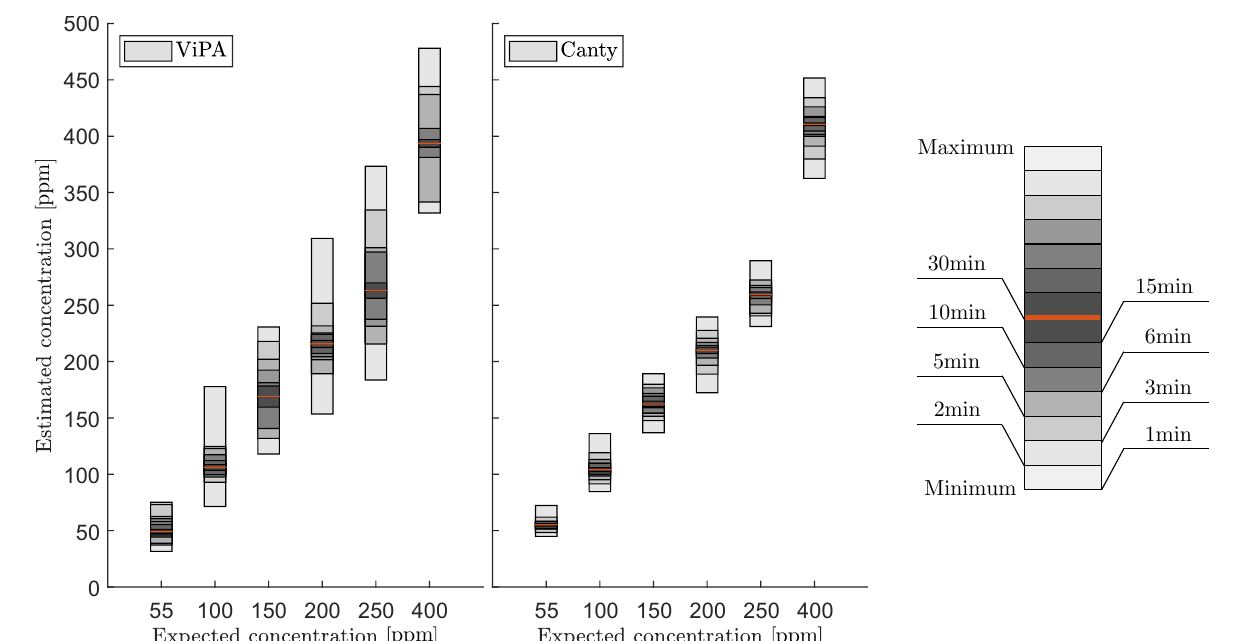
Figure 20. Error bars representing the minimum and maximum OiW concentrations based on different time durations of averaging the OiW concentrations obtained by C 2 and C 3 , respectively. The right error bar illustration shows different time durations according to the greyscale value. The red indicator shows the grand mean of the OiW concentrations obtained within the execution time of 30 min.